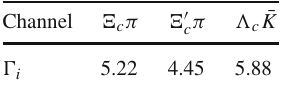
for the pole at 2937.15 MeV in the J P = 1 / 2 − sector with i